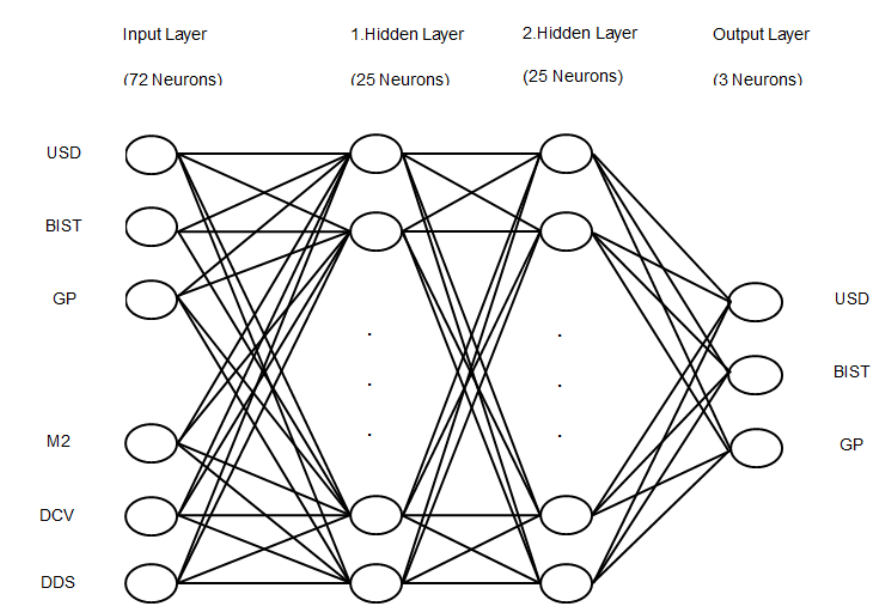
Figure 2. The depiction of the second ANN model constituted with six input layers and three output